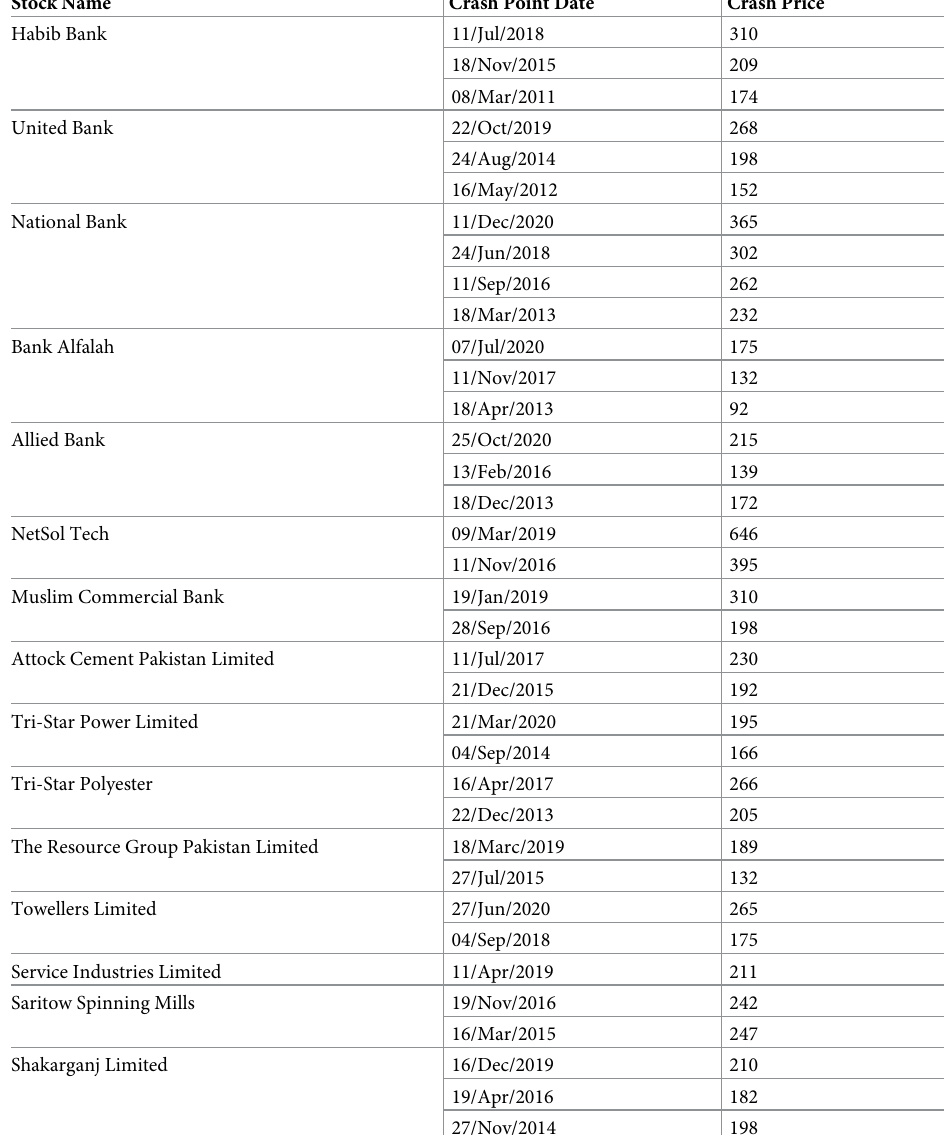
Table 3. Using moving average data, the stock price crisis point is